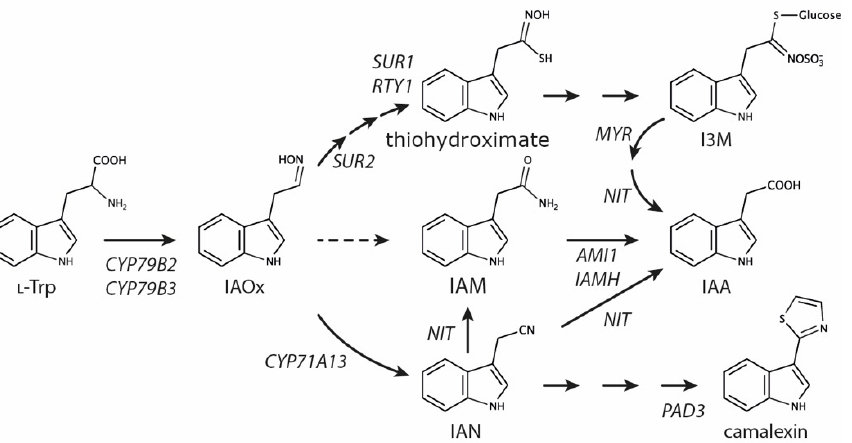
Figure 1. Metabolic pathways of the indole-3-acetaldoxime shunt in Arabidopsis thaliana . Schematic overview of the biosynthesis of L -Trp derived indole glucosinolate, camalexin, and indole-3-acetic acid. Dashed lines indicate reaction steps for which corresponding genes/enzymes have not yet been